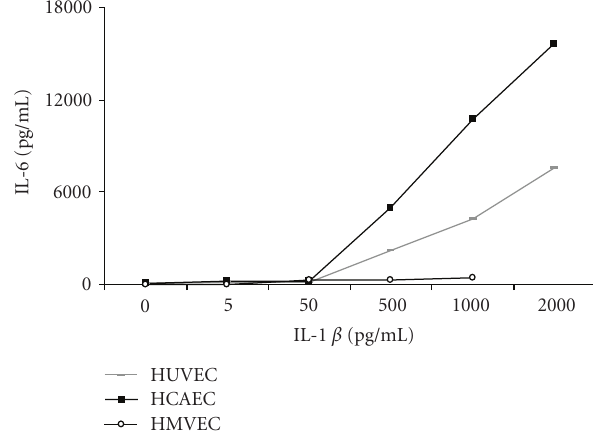
Figure 1: Dose dependent responses of HUVEC, HCAEC, and HMVEC to IL-1 β (0–2000 pg/mL) as measured by ELISA of released IL-6 protein levels from cell supernatants. Results are expressed as a mean of three separate experiments.